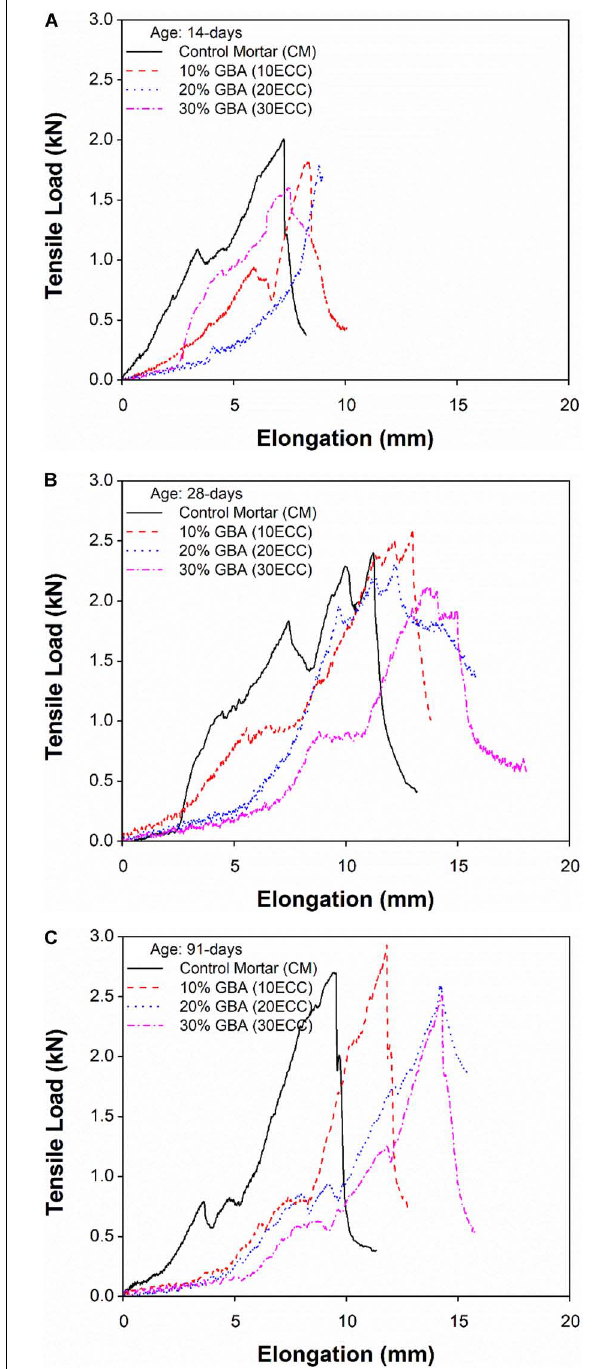
FIGURE 9 | Comparison of elongation among CM and the ECC mixes at an age of: (A) 14, (B) 28, and (C) 91 days.